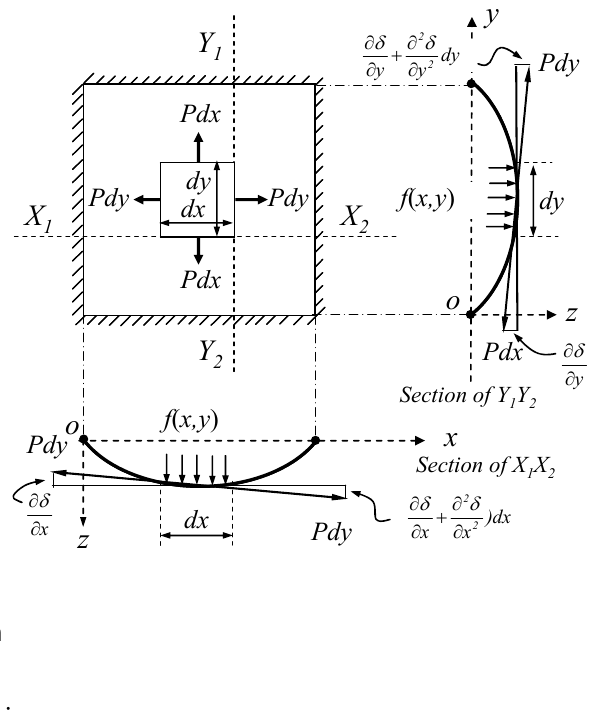
Figure 3. Membrane mechanical deflection of a flexible electronics sensor when a load was